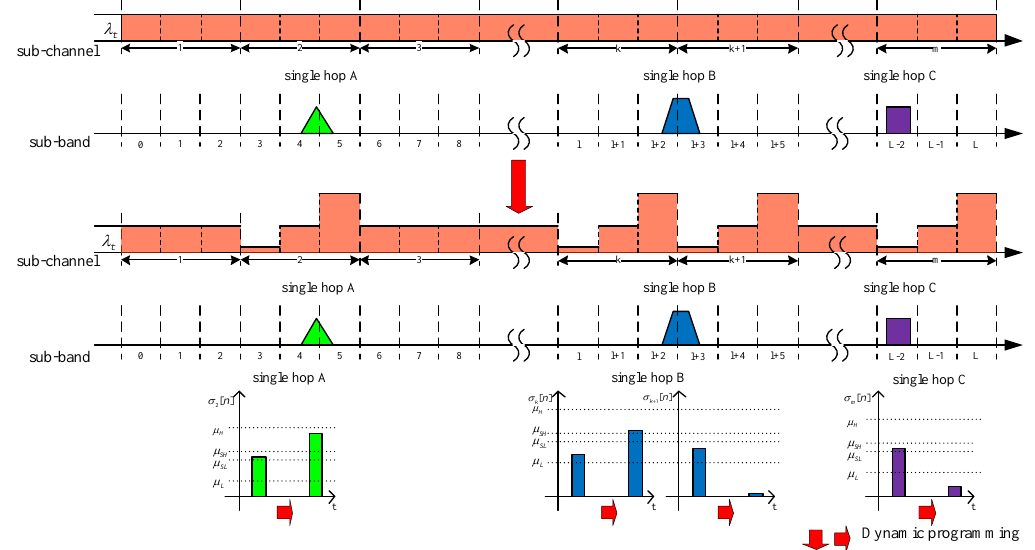
Figure 3. Dynamic programming strategy for support set estimation.